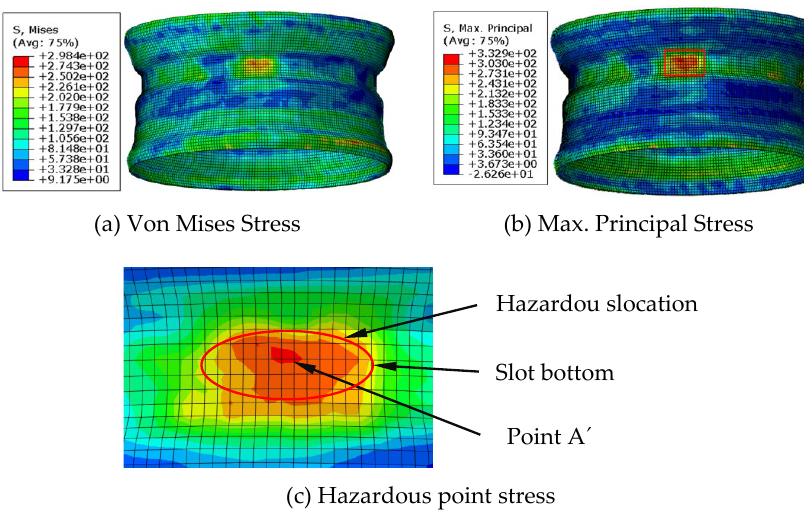
Figure 14. Stress distribution after superposition.